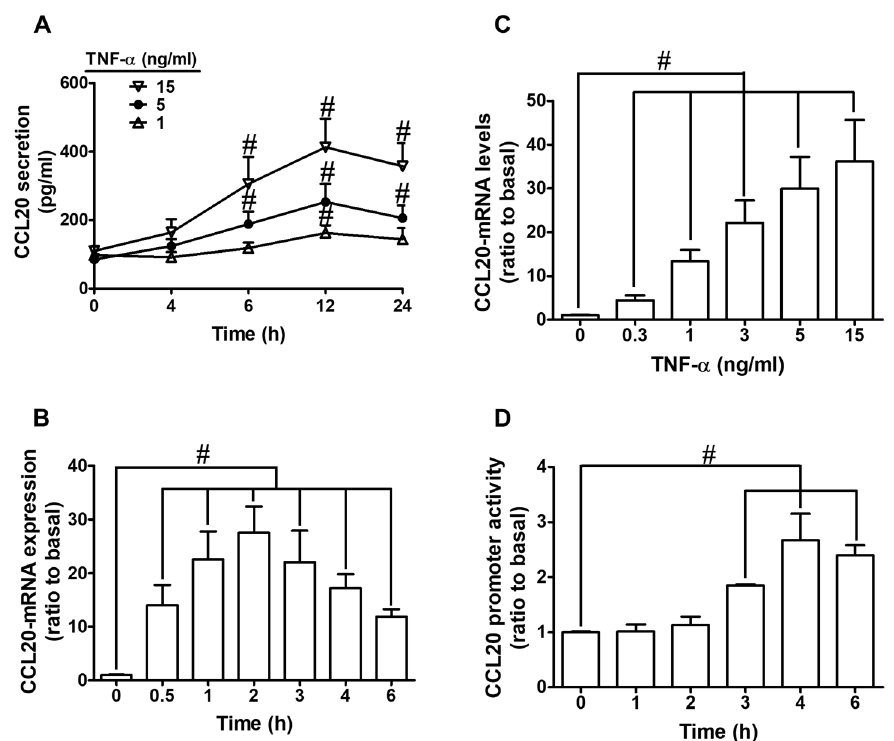
Figure 1. TNF- α induces CCL20 protein secretion and mRNA expression in HCFs. ( A ) Cells were incubated with TNF- α for the indicated time intervals (4, 6, 12, and 24 h). The conditioned media were utilized to determine the CCL20 level via an ELISA kit. ( B , C ) The mRNA levels of CCL20 were determined by real-time PCR. ( B ) Cells were incubated with TNF- α (5 ng/mL) for the indicated time intervals (0.5, 1, 2, 3, 4, and 6 h. ( C ) Cells were incubated with 0.3, 1, 5, and 15 ng/mL TNF- α for 2 h. ( D ) Cells were incubated with TNF- α (5 ng/mL) for the indicated time intervals (1, 2, 3, 4, and 6 h). The promoter activity of CCL20 was determined by a promoter assay kit. Data are expressed as mean ± S.E.M. of three independent experiments ( n = 3). # p < 0.05, as compared with the cells exposed to vehicle